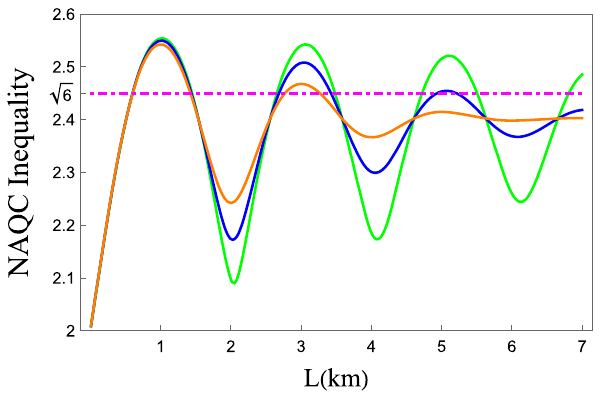
Fig. 3 NAQC and Bell-CHSH inequalities as a function of the dis- tance. The plot is made using the data from Daya Bay experiment: sin 2 2 θ 13 = 0 . 084 ± 0 . 005 and Δ m 2 ee = 2 . 42 + 0 . 10 − = 1 . 25 × 10 − 6 m . The value of the energy is E = 4MeV. The darker σ x